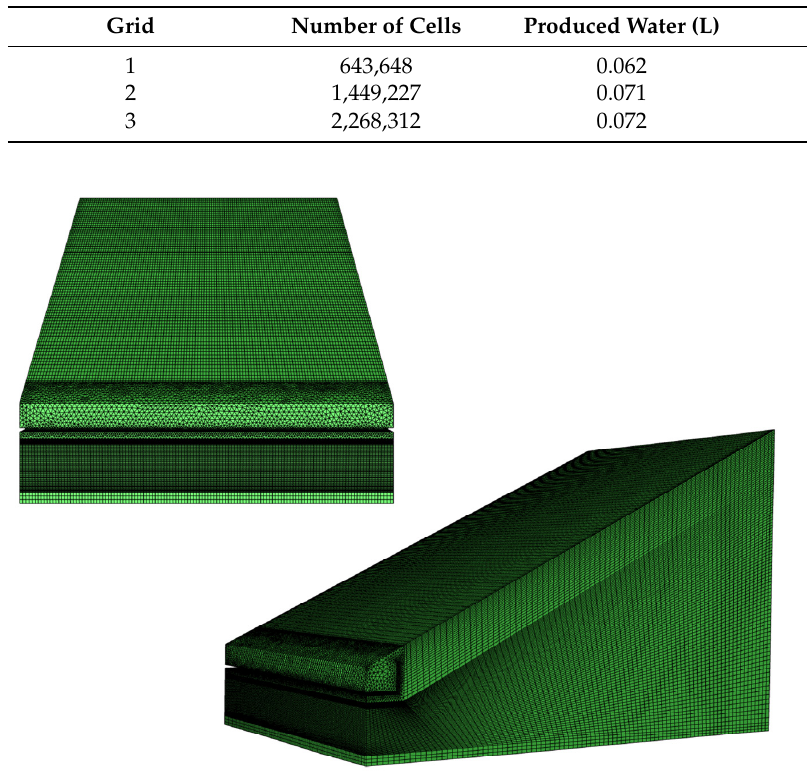
Figure 4. The 3D elements for Grid 2: front view and side view.